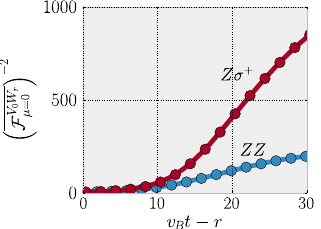
FIG. 5. Space-time structure of the wave front in Fig. 4 at time t ¼ 40 for OTOCs involving the conserved density ˆ Z 0 . We plot ˆ W ˆ Z F − 2 at μ ¼ 0 for ˆ V ¼ ˆ Z ˆ σ þ ¼ r as a function of 0 and r , the distance from the front v B t − r and find a linearly growing regime in both quantities, indicating a decay of the form ffiffiffiffiffiffiffiffiffiffiffiffiffiffi p F ∝ 1 = v t − r . B